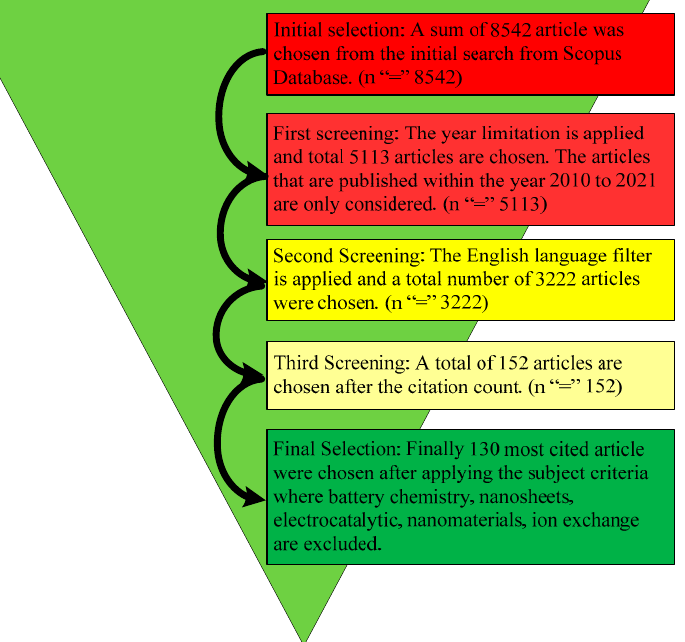
Figure 1. Schematic diagram of the reviewing method.